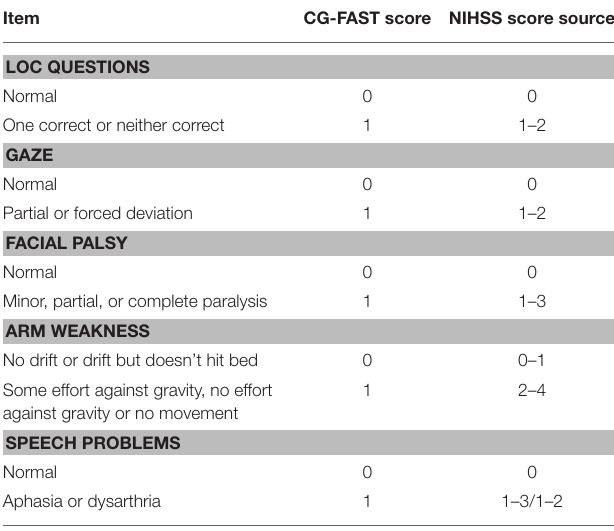
TABLE 1 | The CG-FAST scale and its correspondence to the